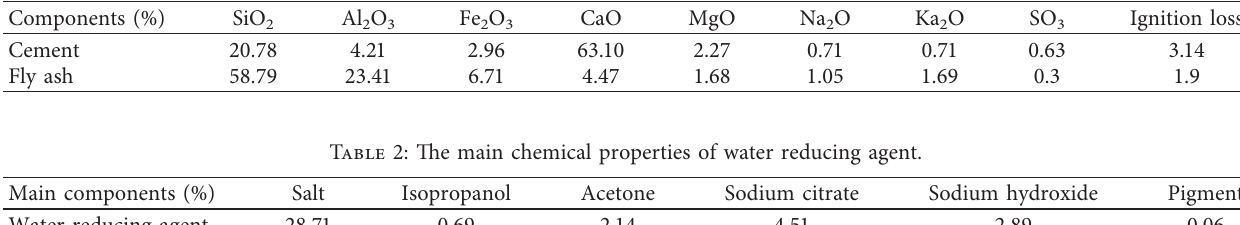
Table 1: The chemical properties of cement and fly